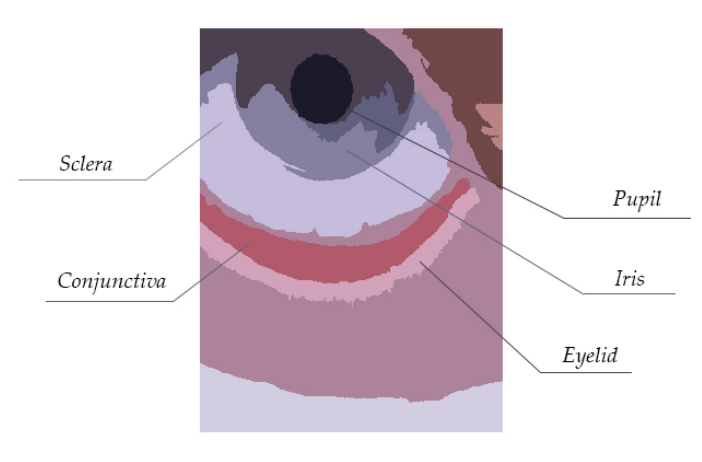
Figure 5. Segmentation output result with semantic class description of eye